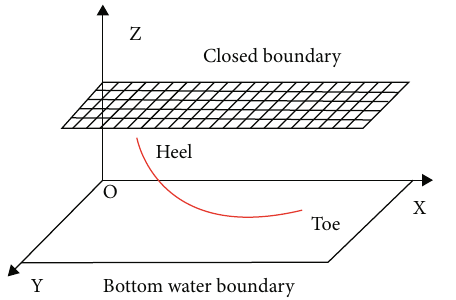
Figure 2: Schematic diagram of horizontal wells in top closed bottom water fl ooding